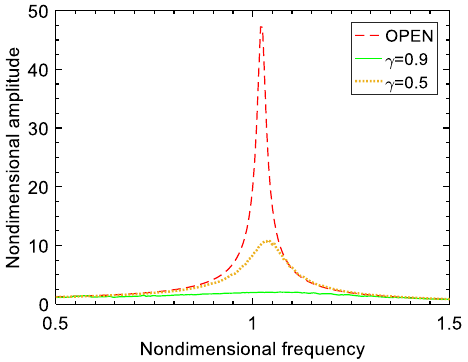
Figure 14. Nondimensional frequency vs. nondimensional amplitude.